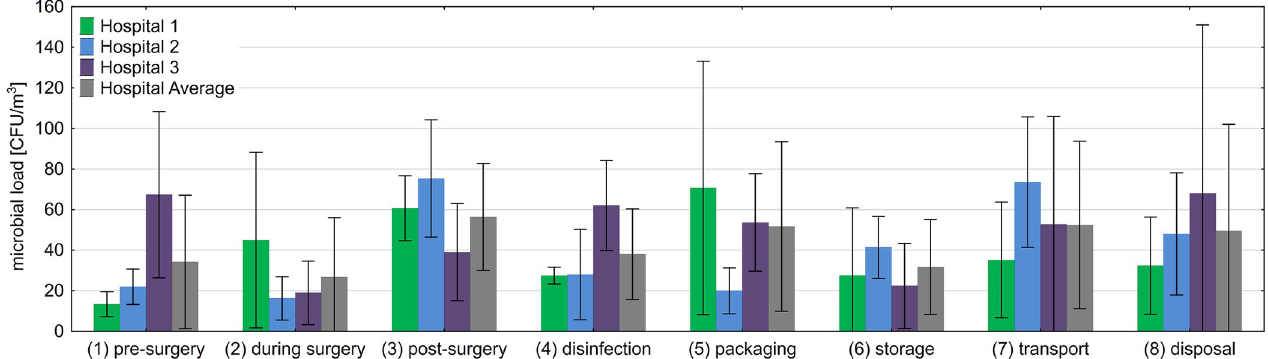
Fig 2. Airborne microbial load measured via active air sampling during use and reprocessing. Mean values and standard deviations of the airborne microbial load of the three hospitals (hospital 1–3, colored bars) and the average load of all hospitals (grey bars) measured during use and reprocessing of sterile goods (1–8) are shown as colony forming units/m 3 [CFU/m 3